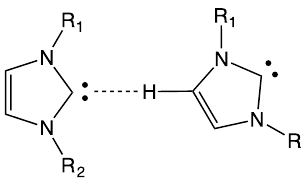
Figure 10. NHC–NHC dimer.